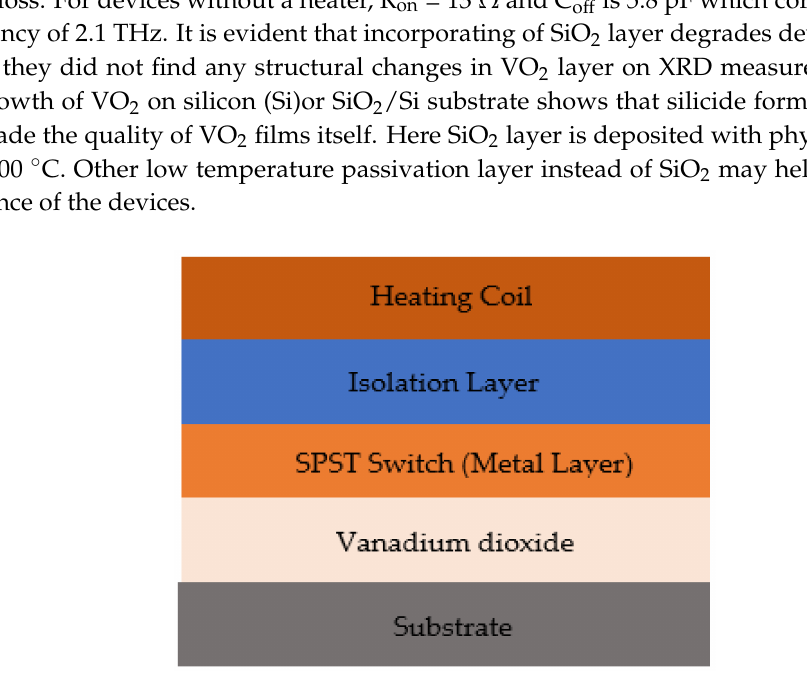
Figure 9. CPW series type devices with integrated heater and silicon dioxide (SiO 2 ) as passivation